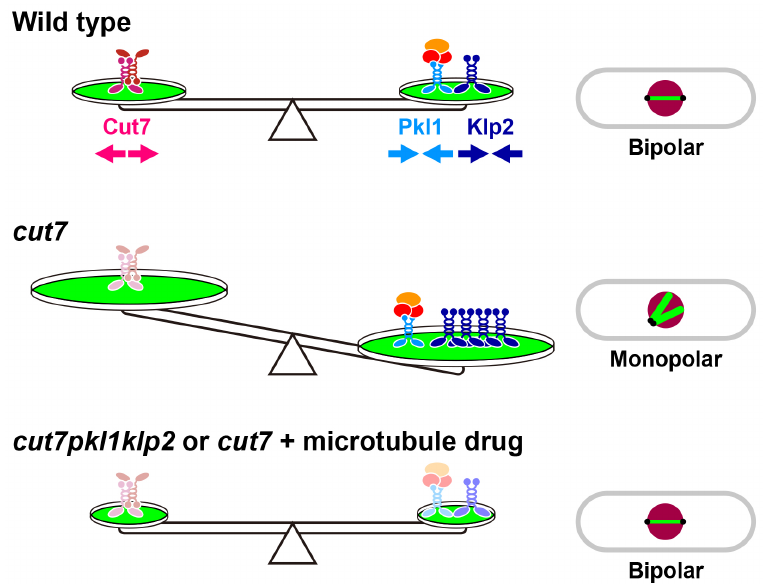
Figure 2. Bipolar spindle formation requires a collaborative force balance exerted by mitotic kinesins, microtubule-associated proteins (MAPs) and microtubule dynamics. In wild type cells (top), Kinesin- 5/Cut7 generates an outward force (red arrows), while Kinesin-14s/Pkl1 and Klp2 generate an opposing inward force (blue arrows). Microtubule stability and dynamics promoted by a cohort of MAPs play positive roles in Klp2 activity by enhancing its localisation to the spindle microtubule, which Kinesin-5/Cut7 opposes. In cut7 ts or cut7∆ cells (middle), Kinesin-14-mediated inward forces dominate, leading to the formation of monopolar spindles. In double mutants between cut7 and pkl1 / klp2 or the cut7 mutant treated with microtubule-depolymerising drugs (bottom), loss of inward forces or the compromised microtubule dynamics, respectively, renders Cut7 dispensable for bipolar spindle assembly and therefore promotes survival.